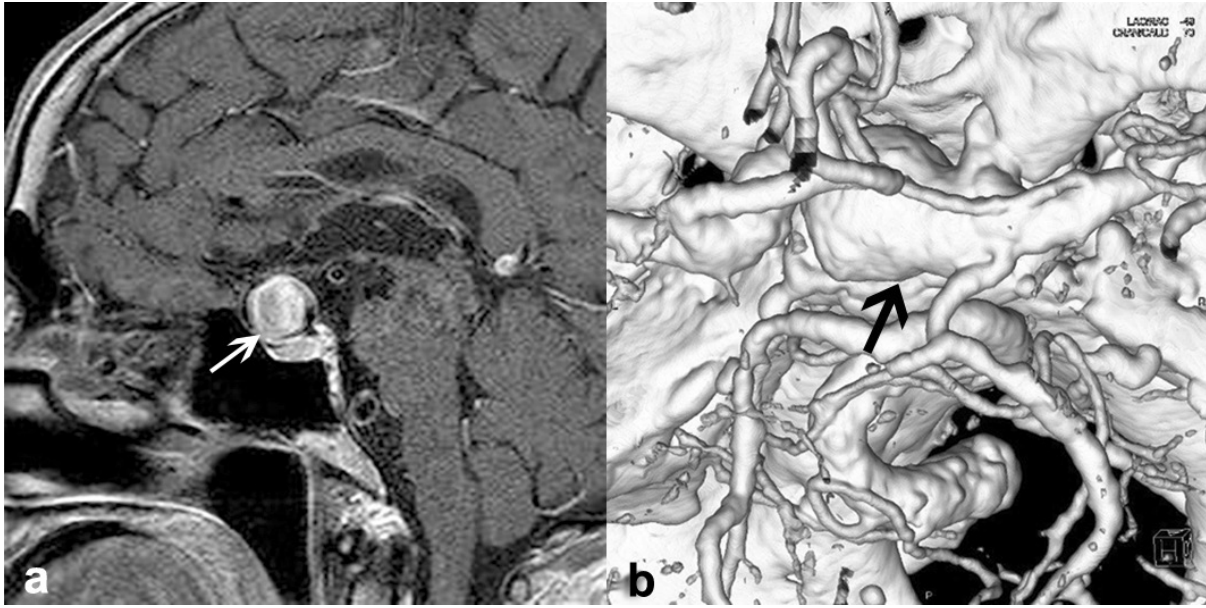
Figure 1: Pre-treatment magnetic resonance imaging (MRI) and computed tomography (CT) angiography of the aneurysm MRI T1-weighted sequences mid-sagittal section with contrast (a) shows a large intrasellar lesion (white arrow) with an unusual pattern of enhancement, which is different from a pituitary adenoma and necessary for further investigation for an aneurysm. CT angiography 3D reconstruction (b) demonstrates a large right supraclinoid ICA aneurysm (black arrow) extending into the sellar region.